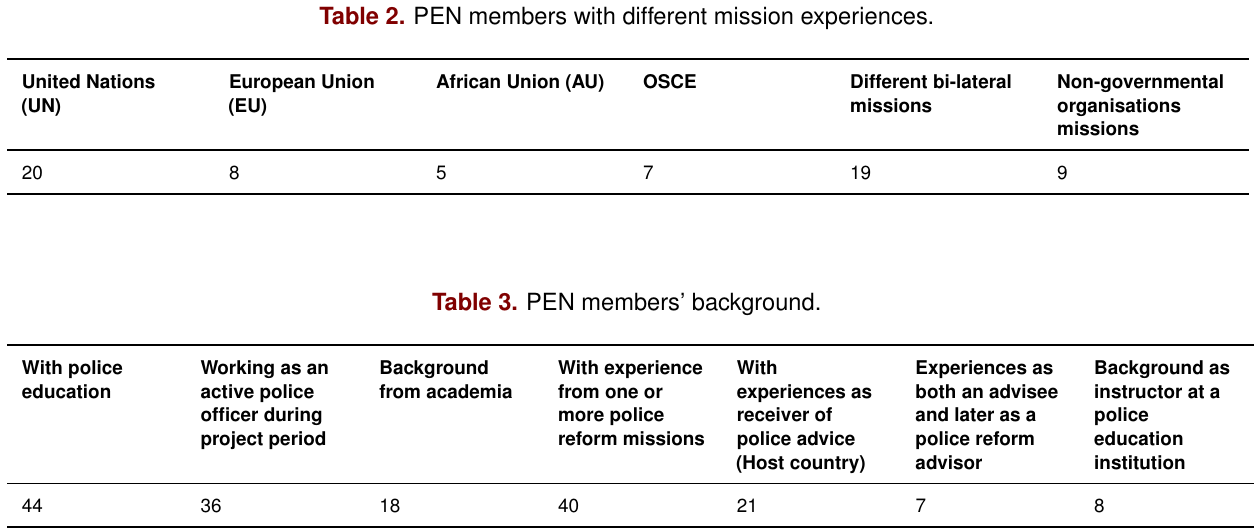
Table 2. PEN members with different mission experiences.